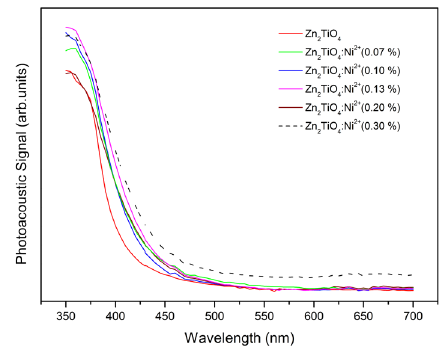
Figure 3. Room temperature photoacoustic absorption spectra of